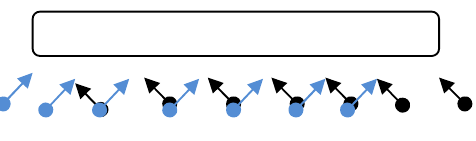
Figure 7. photography positions for a façade.